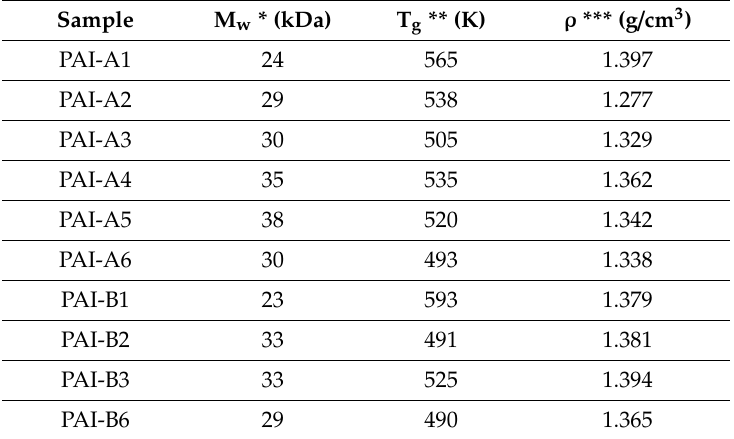
Table 1. Characteristics of the studied polyamidoimides (PAI).